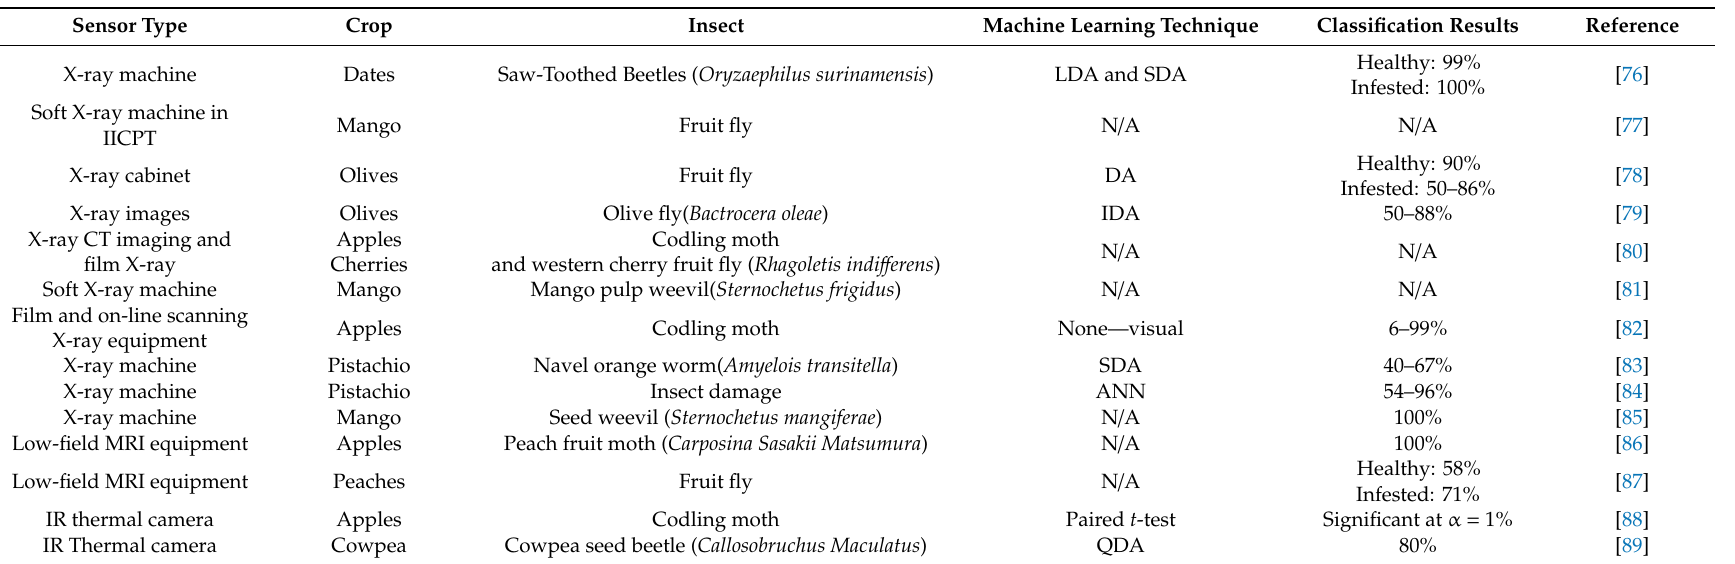
Table 3. Studies of detecting insect infestations in fruits and vegetables using X-ray imaging, MRI, and thermal